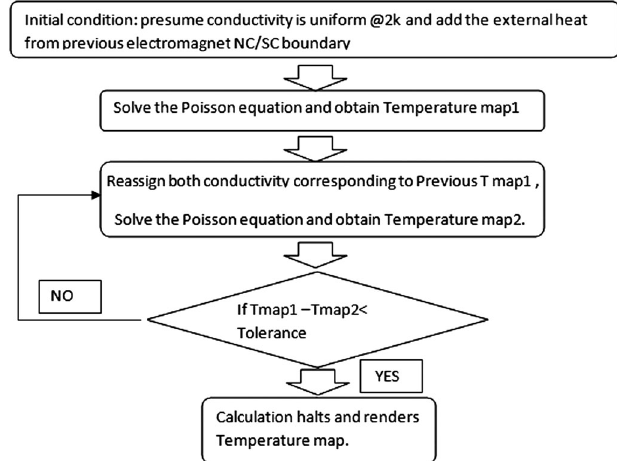
FIG. 9. The flowchart of thermal equation simulation. It is used to calculate the temperature distribution.